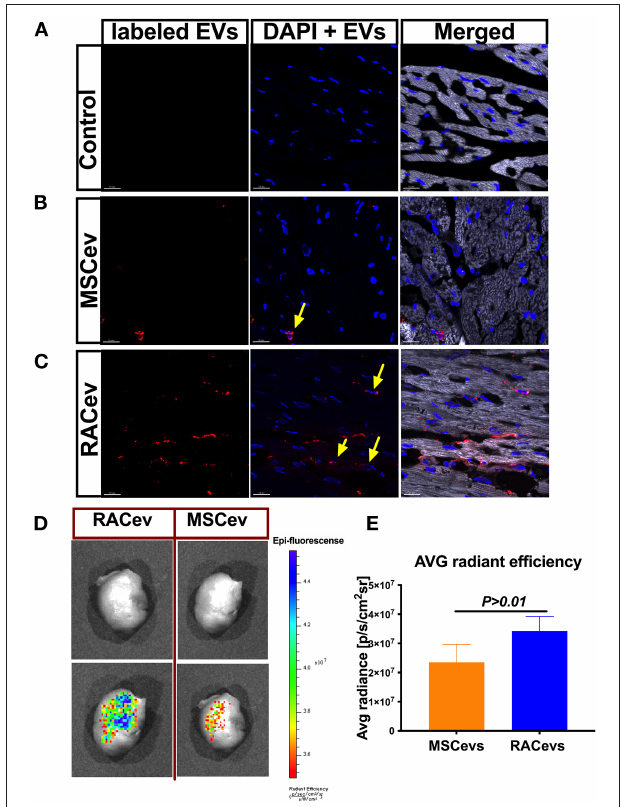
FIGURE 6 | RACev preferentially accumulates to the ischemic myocardium. Representative histological findings of infarcted tissue (A) in control groups; (B) MSCev showed less infiltration in the ischemic myocardium, whereas (C) large amount of RACev accumulated into the infarcted tissue, and the labeled some RACev (red color) were internalized into the cardiomyocyte nuclei (yellow arrows; nuclei stained with Hoechst). (D,E) in vivo imaging system (IVIS) imaging showed large accumulation of labeled RACev into the infarcted left anterior ventricle. All experiments were repeated twice with the same results. Statistical significance was determined using the Mann-Whitney U test. The results are presented as mean ± SEM ( n = 6 per